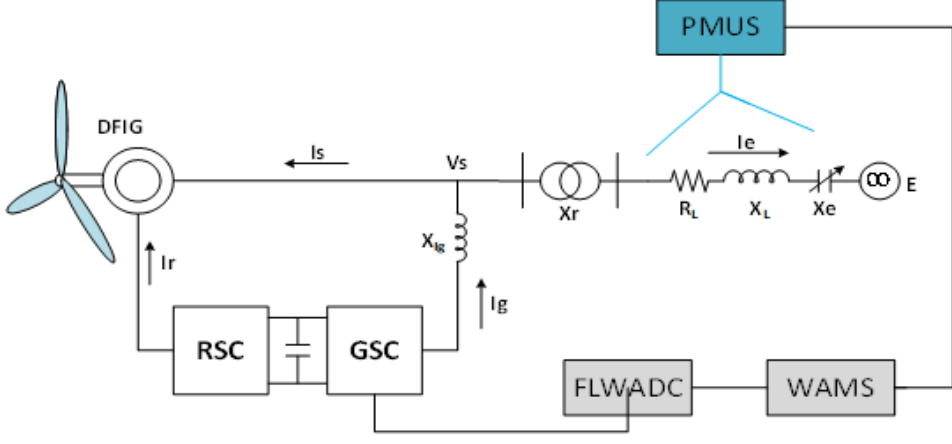
Figure 4. Hierarchical structure of a Wide Area Measurement System with PMUs.